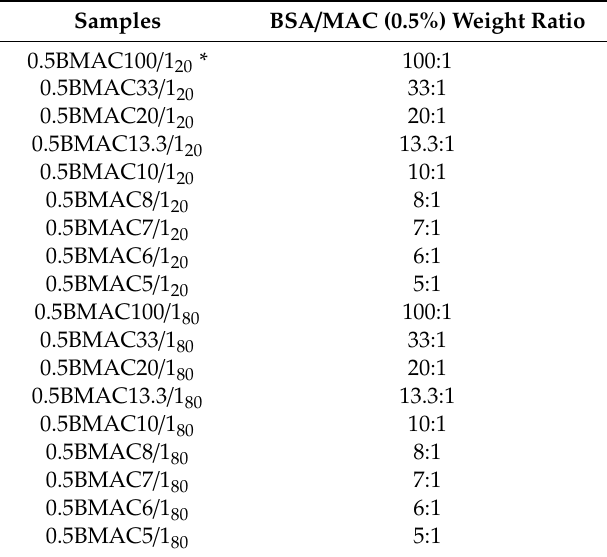
Table 1. Notation of bovine serum albumin (BSA) / maleic anhydride chitosan derivative (MAC nanogels formed at 0.5% polymer